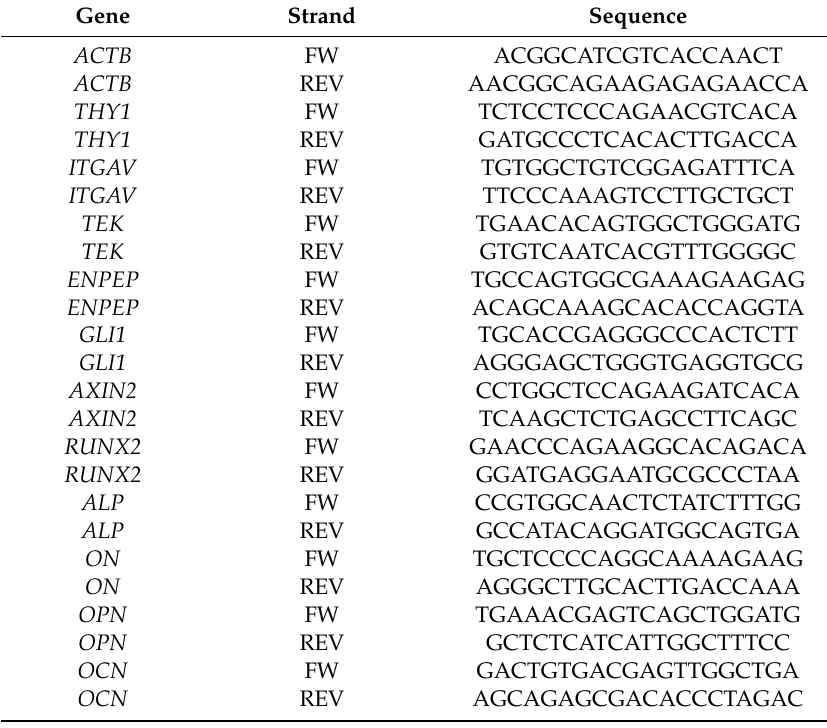
Table 1. Primer pairs for